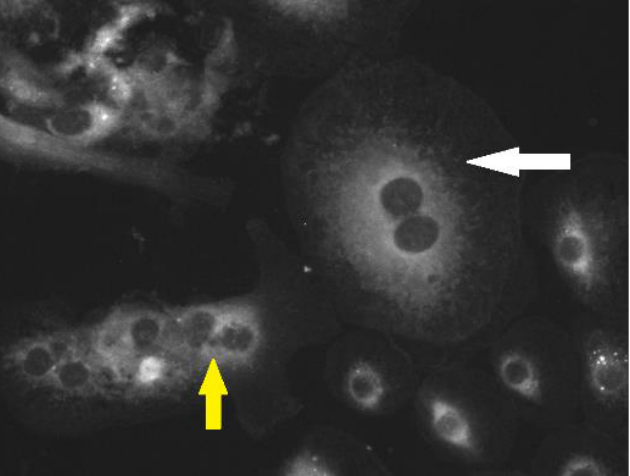
Figure 1. Uninfected embryonic cockatiel brain cells, including a large pleomorphic cell with two nuclei (white arrow) alongside smaller cells with multiple nuclei (yellow arrow).